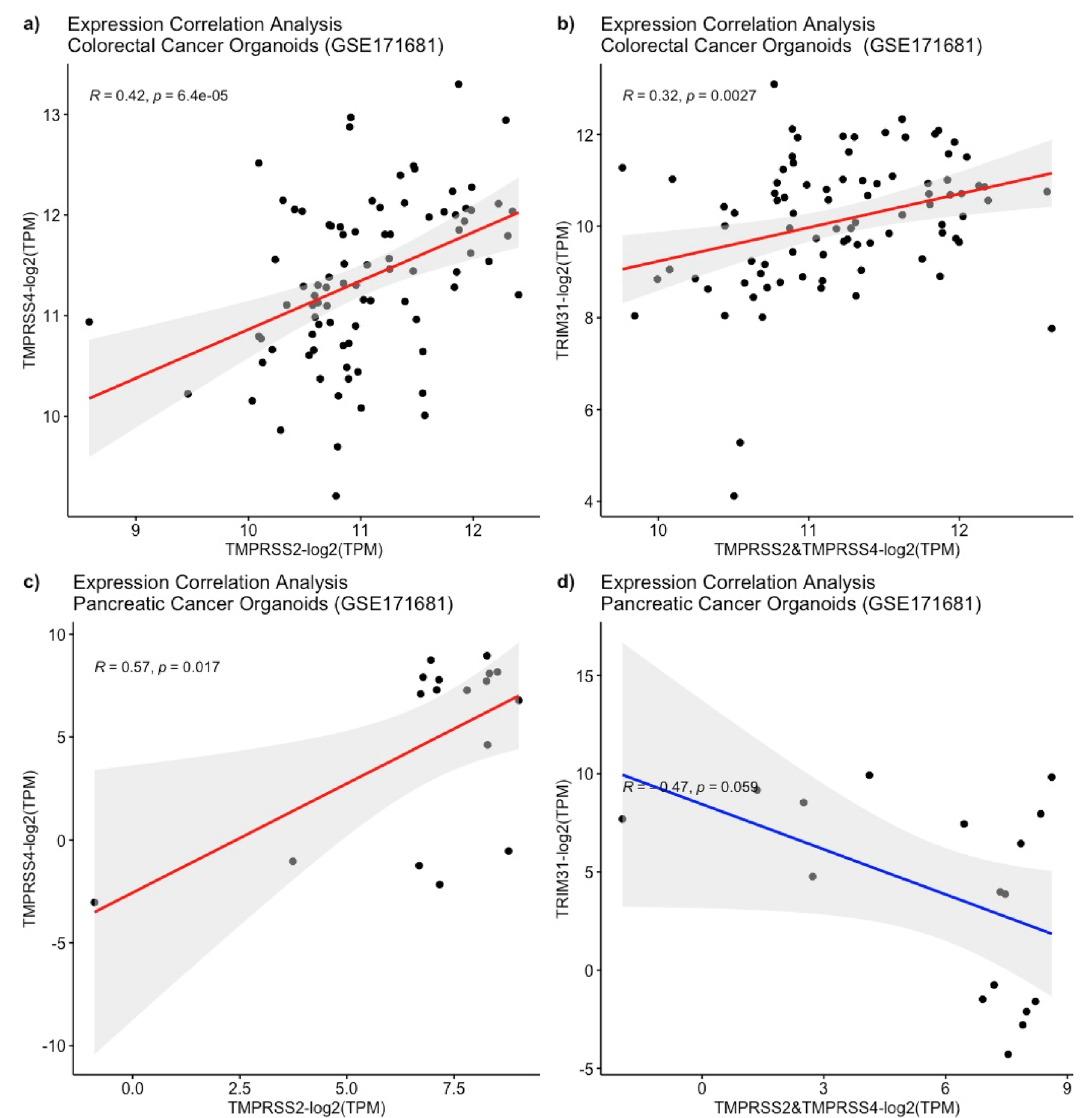
Figure 5. Correlation analysis of the TMPRRS2, TMPRSS4 and TRIM31 genes across patient derived organoids. Positive correlation between TMPRSS2 & TMPRSS4 and TRIM31 was observed in colorectal cancer organoids (n = 87) ( a,b ). Only TMPRSS2 shows a significant positive correlation with TMPRSS4 (n = 17) but no significant correlation is observed between the serin protease pair and TRIM31 in pancreatic cancer organoids ( c,d genes marked with blue circles. This analysis demonstrated that the loss of TRIM31 affects viral transcription (GO:0019083) (p-Value = 2.36e−17) and viral processes (GO:0016032) (p-Value = 5.50e−08) with a false discov- ery rate; p-value < 0.05 (Fig. 6b). A list of downregulated genes interacting in 18 nodes are presented (Fig. 6c). Considering most of these genes are involved in viral transcription and viral processes, TRIM31 is likely to play such as SARS-CoV-2, seen in cancer patients.